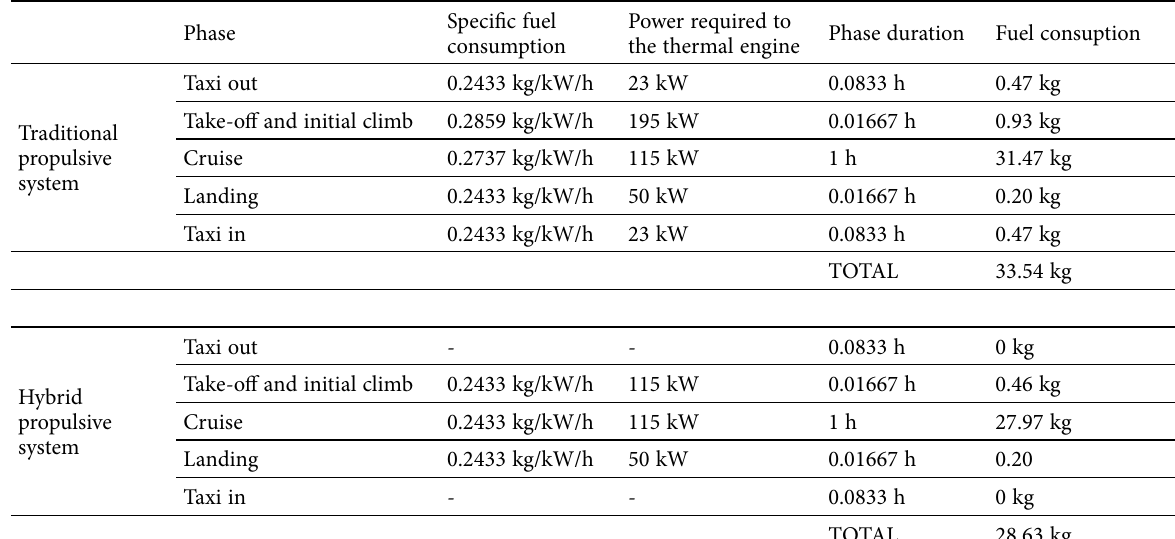
Table 8. Fuel consumption comparison between traditional and hybrid propulsive system